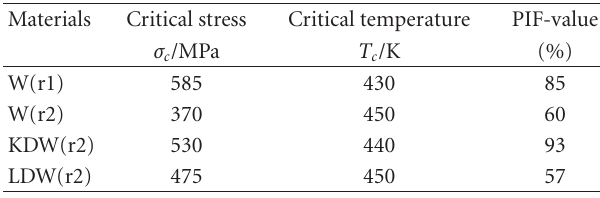
Table 1: Summaries of critical stress, critical temperature, and PIF- value for various materials.